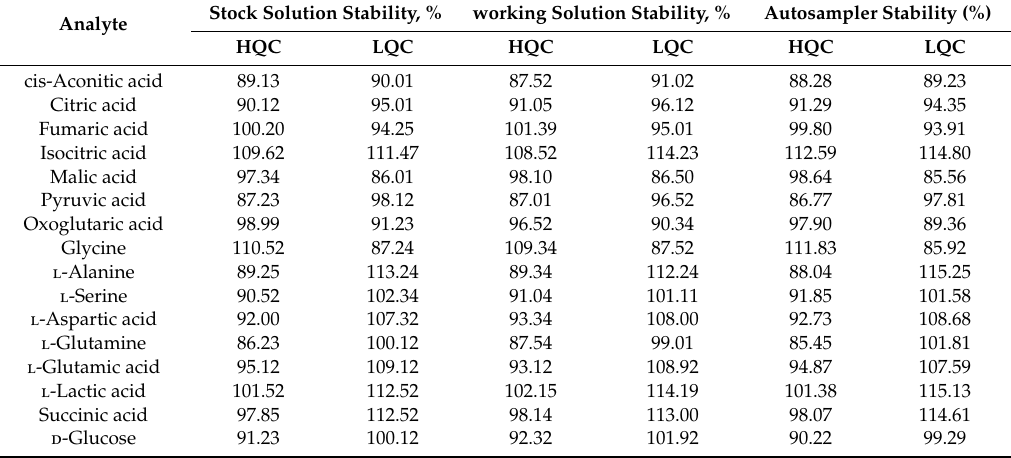
Table 3. Results of stability for stock solution, working solution, and autosampler of TCA cycle